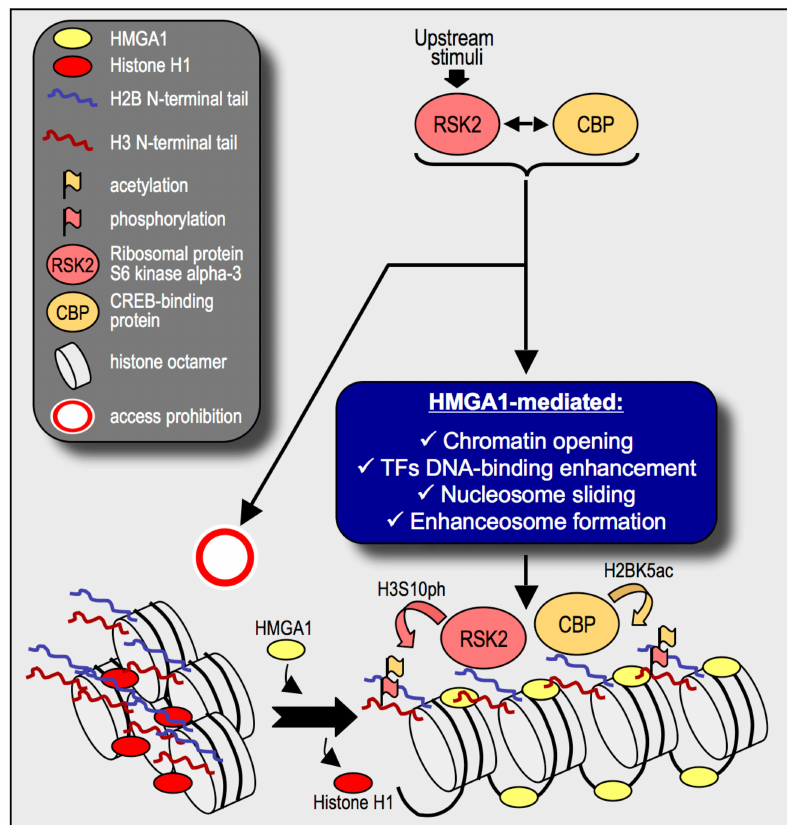
Figure 9. Expanding High Mobility Group A1 (HMGA1) chromatin functions. HMGA1 participates in the chromatin opening process by displacing histone H1 from chromatin via a competitive mechanism. Once bound to nucleosomes and / or DNA, HMGA1 is involved in the recruitment of transcription factors (TFs) and in the formation of protein platforms for the landing of other chromatin proteins [17,23]. In this work, we provided evidence that in triple negative breast cancer (TNBC) cells HMGA1 could be an essential co-factor for conveying onto chromatin ribosomal protein S6 kinase alpha-3 (RSK2) and CREB-binding protein (CBP)